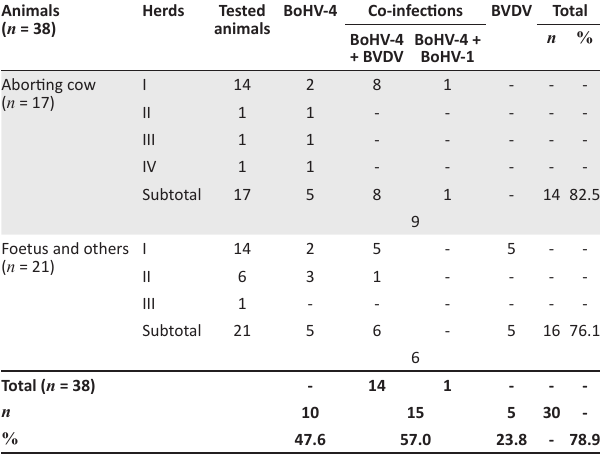
TABLE 2: Results according to sampled herds and clinical cases. Animals Herds Tested ( n = 38) animals